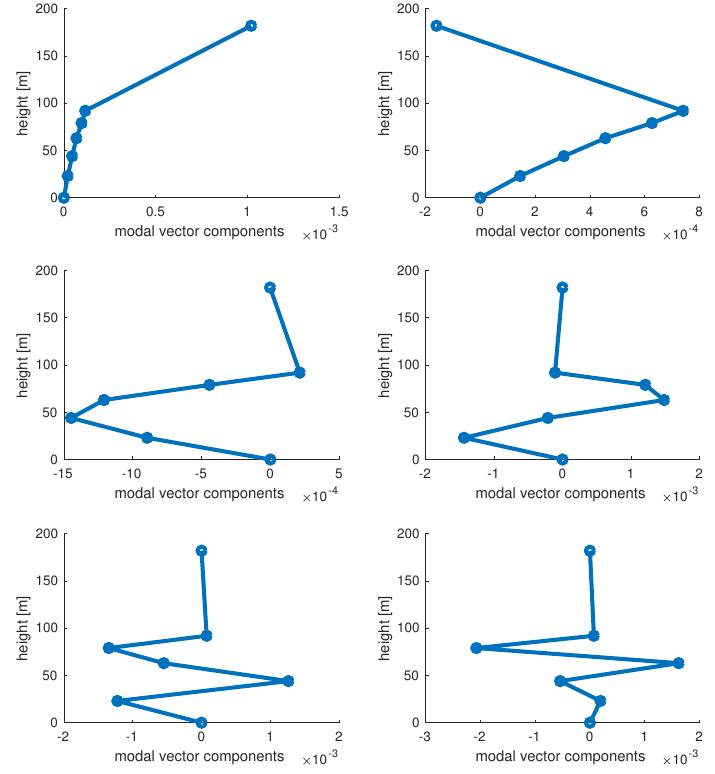
Figure 15. Crown pile vibration